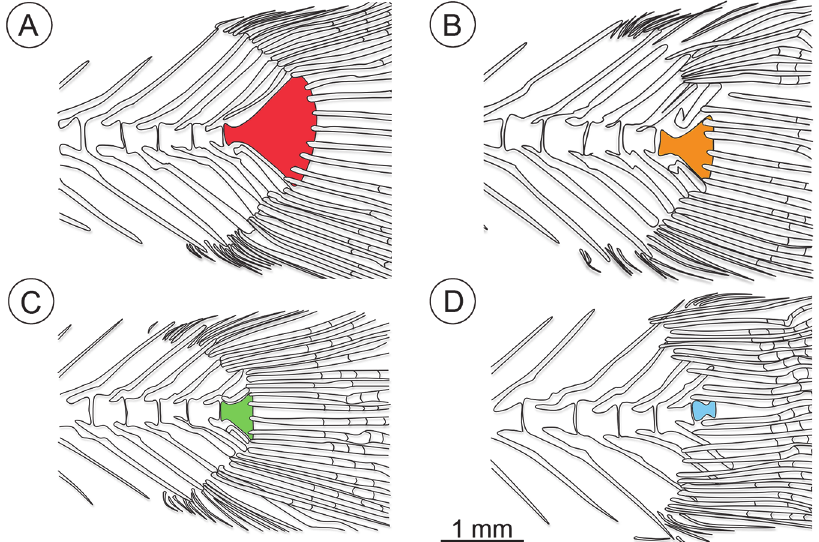
Fig 10. Reconstructions of the caudal skeletons of four specimens of † K . kipkechi sp. nov. showing the polymorphism in the hypural plate dimensions. A , paratype 1237R(1)´04; B , paratype 1206(1)´04; C , paratype 1168´04; D , paratype 1146´04 (mirrored).